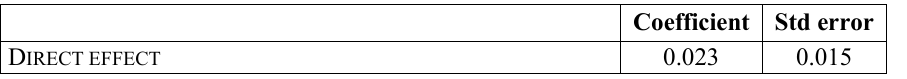
Table 5: Direct, Indirect, and Total Effects of HC Operational on